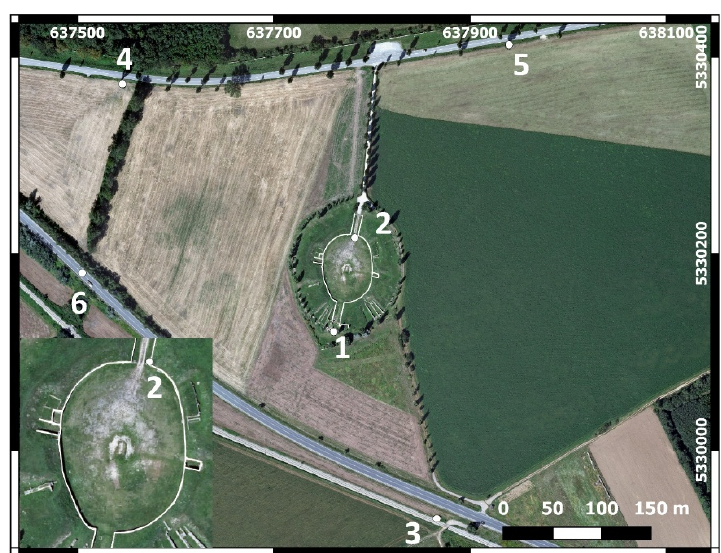
Figure 6. Orthophotograph that covers the civil amphitheater in Carnuntum, which is used to validate the positional accuracy of the monoplotted images (using the indicated outlines and Points 1–6). Remote Sens. 2016 , 8 , 209 Background orthophotograph: © County of Lower Austria, 2008. Background orthophotograph: © County of Lower Austria, 2008.